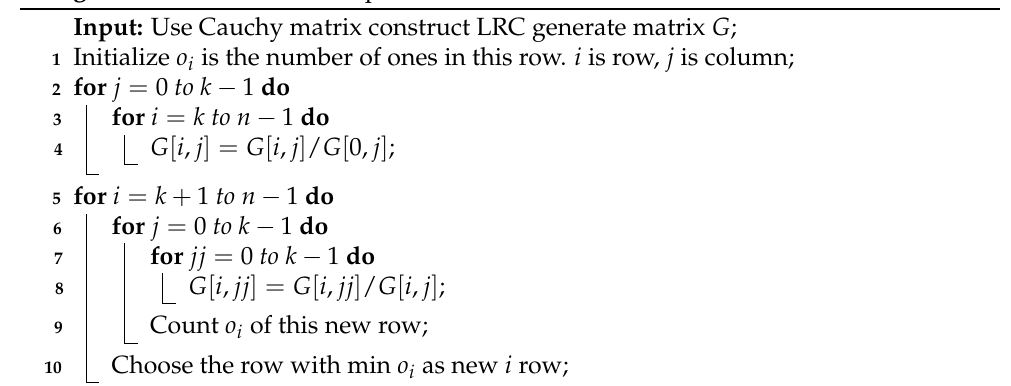
Figure 5. The bitmatrix representation of all elements over the finite field GF ( 2 3 ) . Gray represents binary 1, white represents binary 0. Algorithm 4: Find the local optimal bitmatrix of